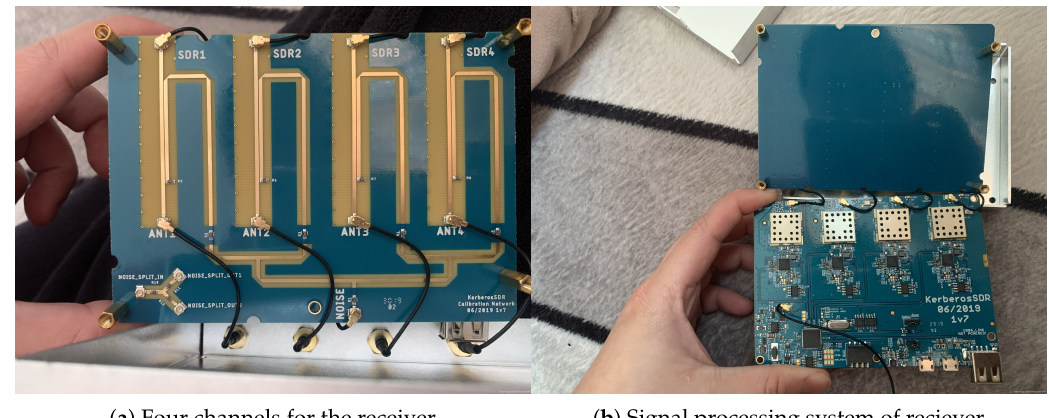
Figure 2. Internals of the spatial spectrum direction finding